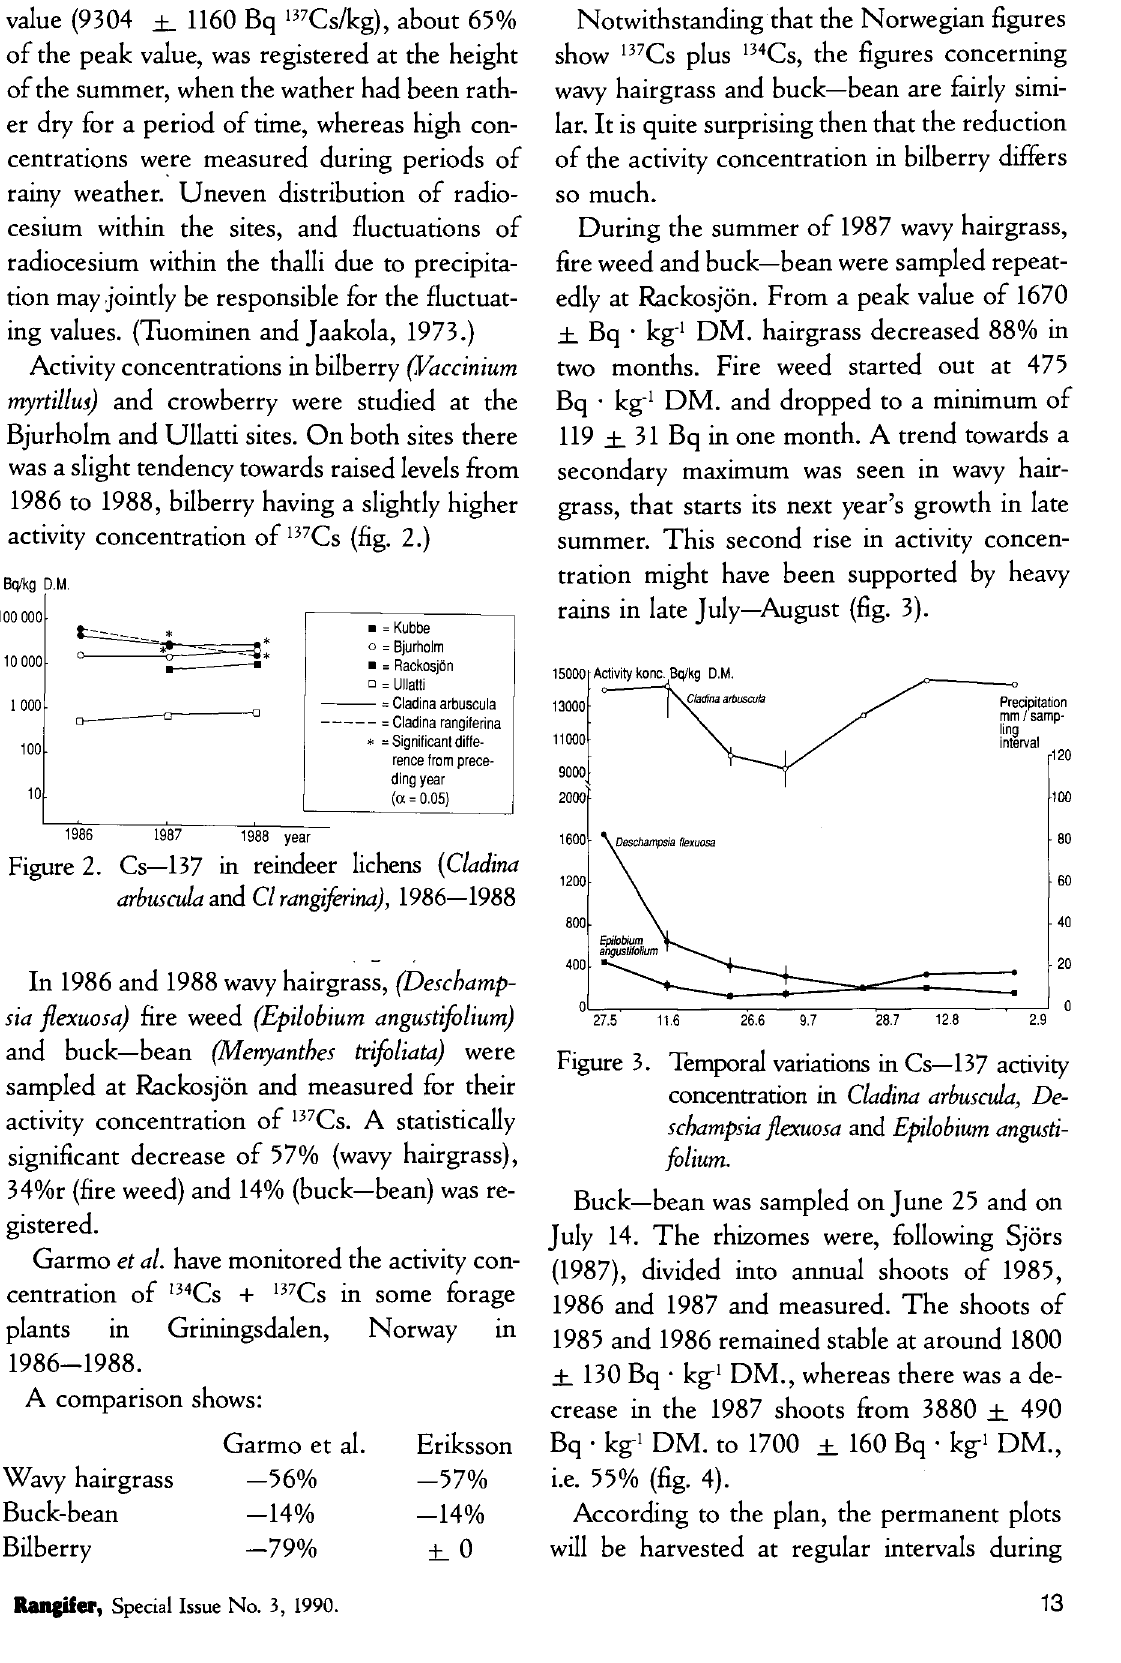
Figure 3. Temporal variations in Cs—137 activity concentration in Cladina arbuscula, De- schampsia flexuosa and Epilobium angusti